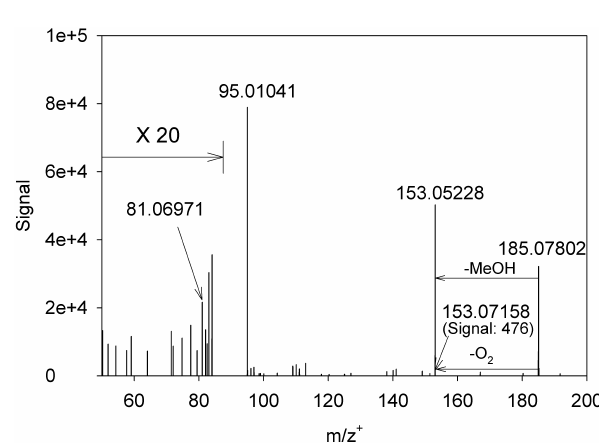
Figure 5. FTICR-MS/MS for m/z + 185 (PHA std )